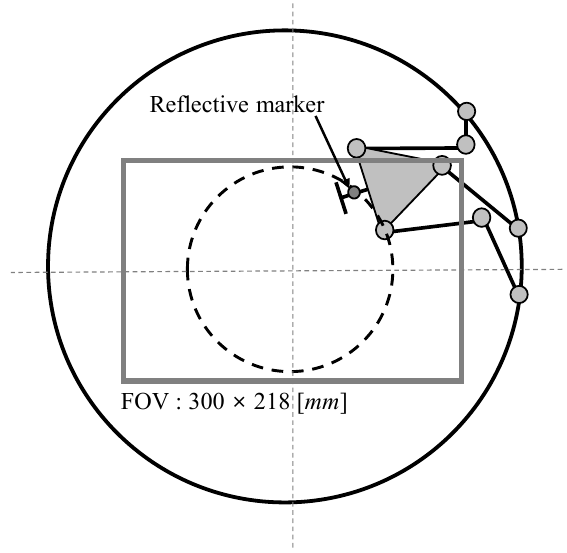
Figure 9. Schematic of the FOV and marker position.